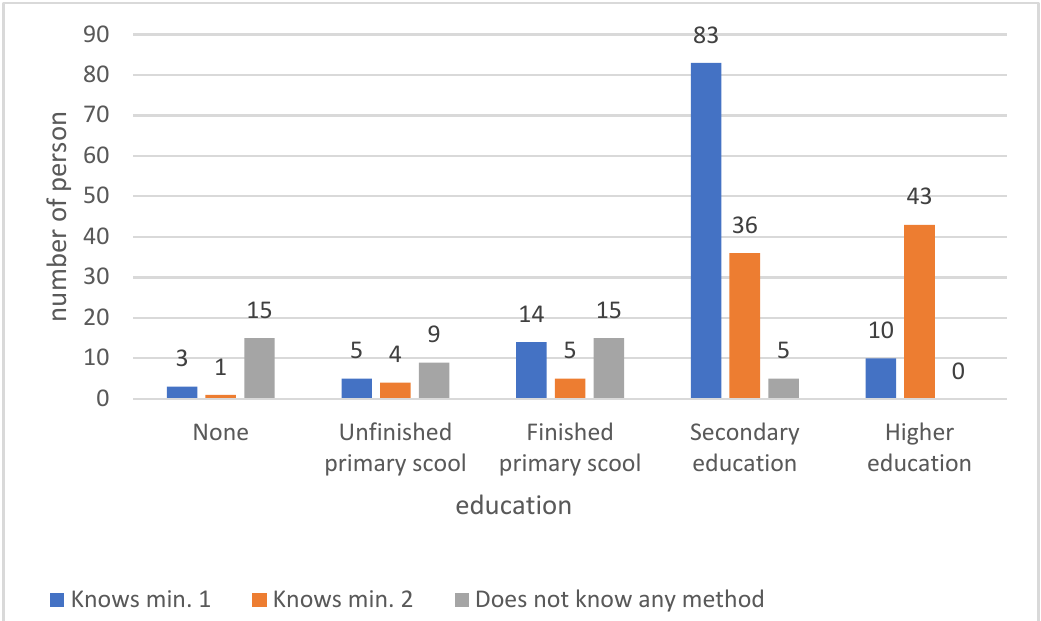
Figure 7. Knowledge of alternative methods of malaria prevention according to education. The respondents who did not consult their doctor before taking an antimalarial drug